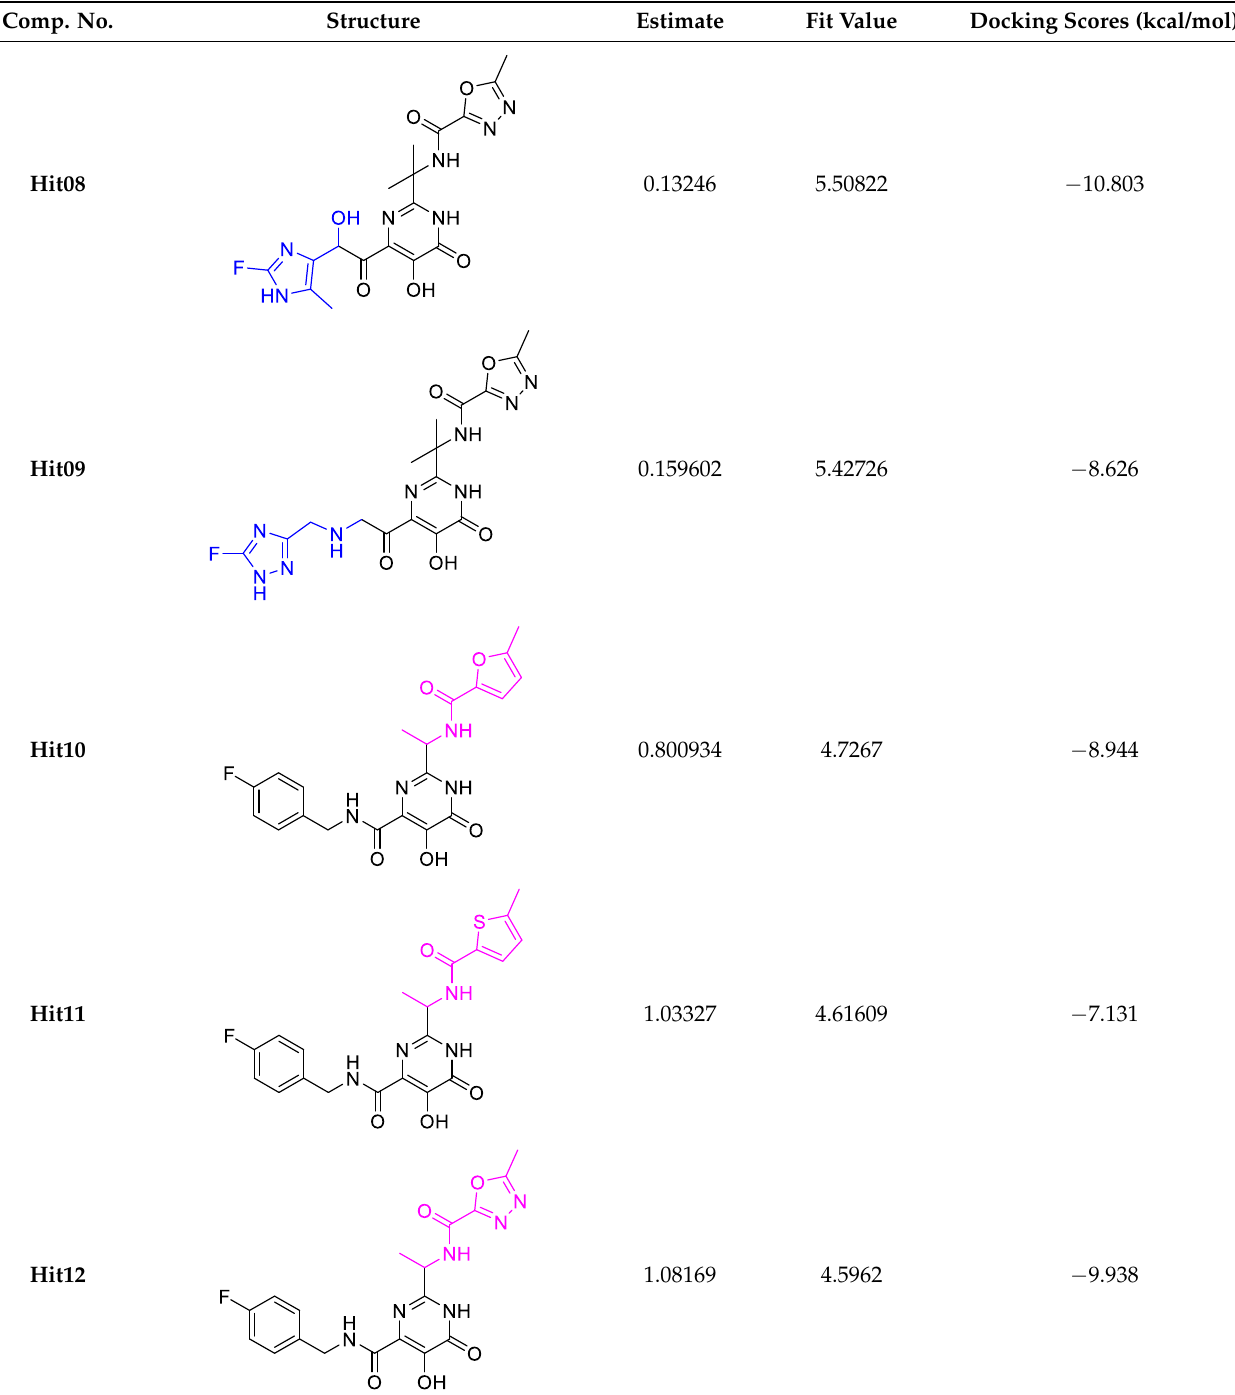
Figure 7. The pathway to elicit compounds ( Hit07 – Hit12 ) from template molecule ( Hit01 ) using side-chain hopping. The docking scores of selected candidate compounds ( Hit07 – Hit09 and Hit10 – Hit12 ) were lower than Hit01 , except Hit07 and Hit11 . Furthermore, the estimated activity values of all compounds were more declined than Hit01 (estimated activity value was 1.16424